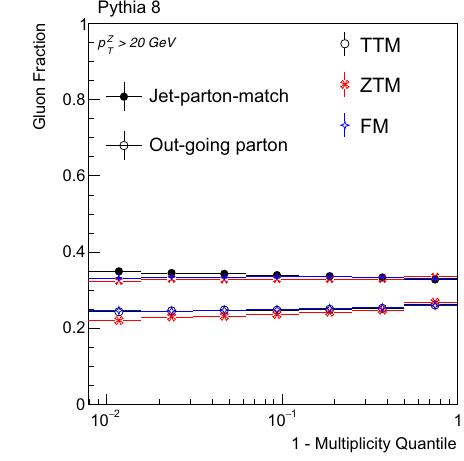
nature of a jet; we show two different definitions: jet-parton-match is the type of the highest energy parton found within the (cid:6) R < 0 . 4 of the jet axis and out-going parton is the type of the out-going parton from the matrix element. Higher multiplicities are to the